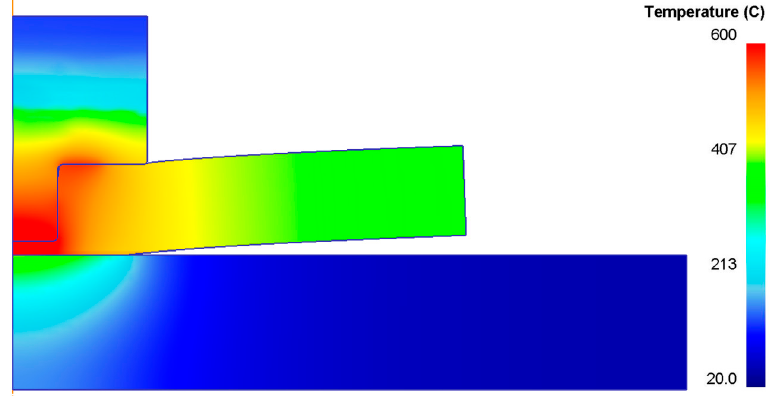
Figure 9. Example of FEM output (S = 5000 rpm, F = 10 mm/min, d = 3.8 mm).